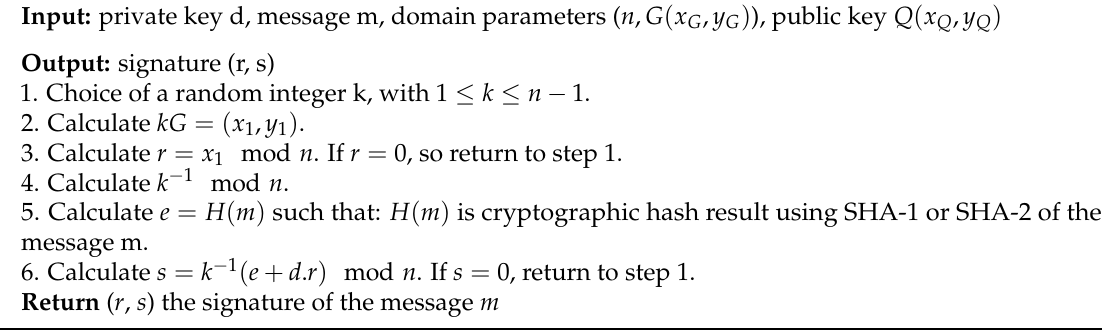
Algorithm 4 : ECDSA signature verification.